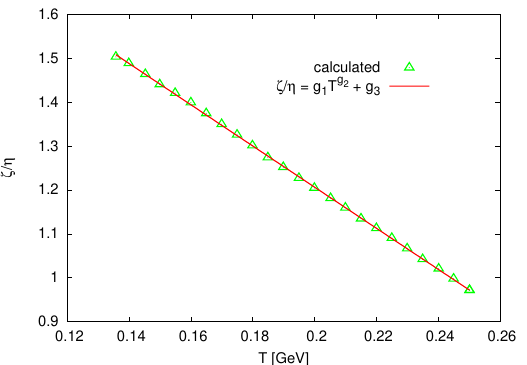
Figure 3. Pressure p is drawn in dependence on the energy density ρ . Symbols are lattice QCD calculations along trajectories of constant S / N = 51 [22]. The solid curve refers to the statistical fit, Equation (12).